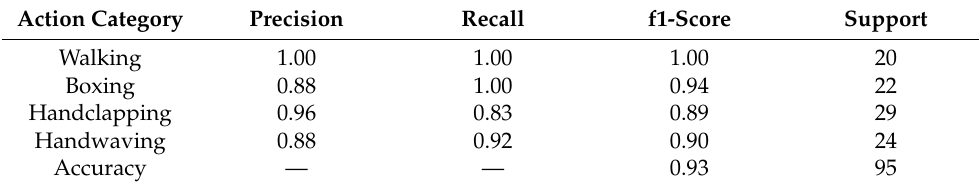
Table 6. Classification results for SC using KNN-DTW with KTH-4.